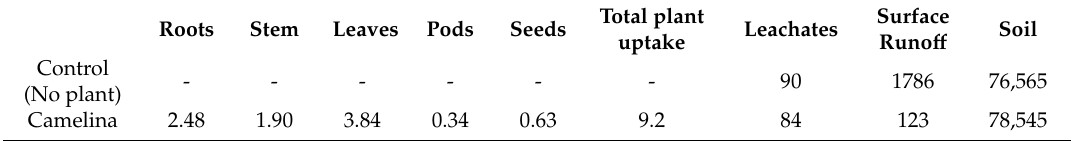
Table 4. Mass balance of Cu (mg) in the greenhouse panel